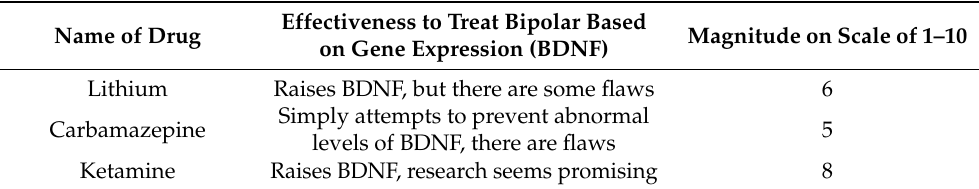
Table 4. Effectiveness of drug treatments based on Gene Expression Data. Data received from CMapPy and validated with research. BDNF is the Brain-Derived Neurotrophic